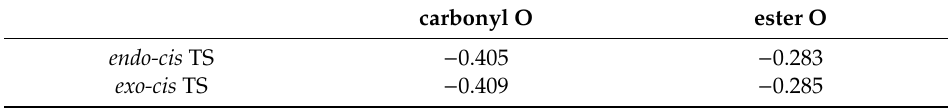
Table 3. CM5 Charges for the Carbonyl and Ester Oxygen Atoms on Methyl Acrylate for the representative endo-cis and exo-cis Diels-Alder transition structures using M06-2X /